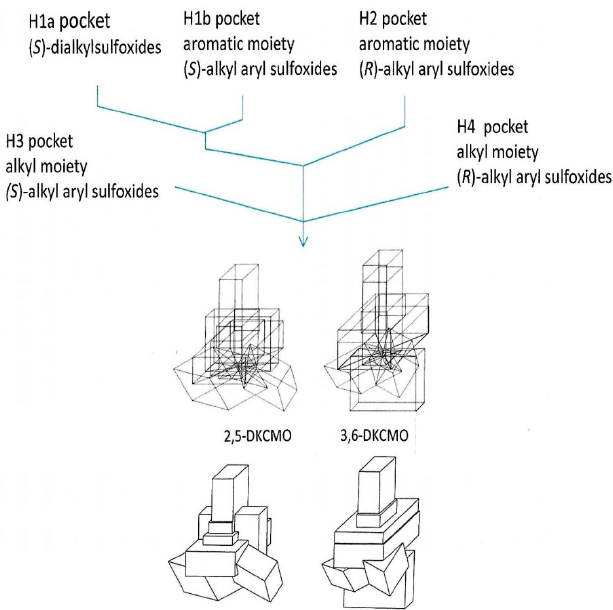
Figure 10. Rationale for superimposing the minimalised structures of the sulfoxides formed by 2,5-DKCMO and 3,6-DKCMO, and the resultant total dimensions (‘cubic space’) of the relevant enzyme active sites.